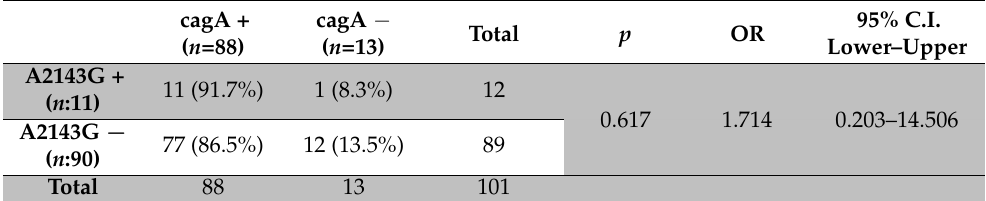
Table 9. The distribution of A2143G mutation by cagA status in all age